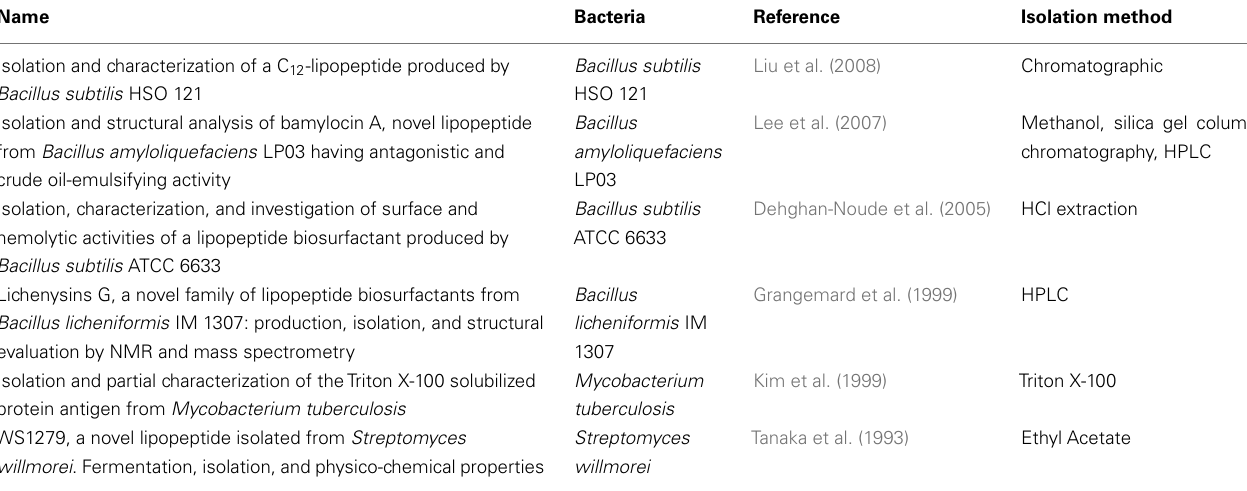
Table 3 | Isolation of different Gram-positive